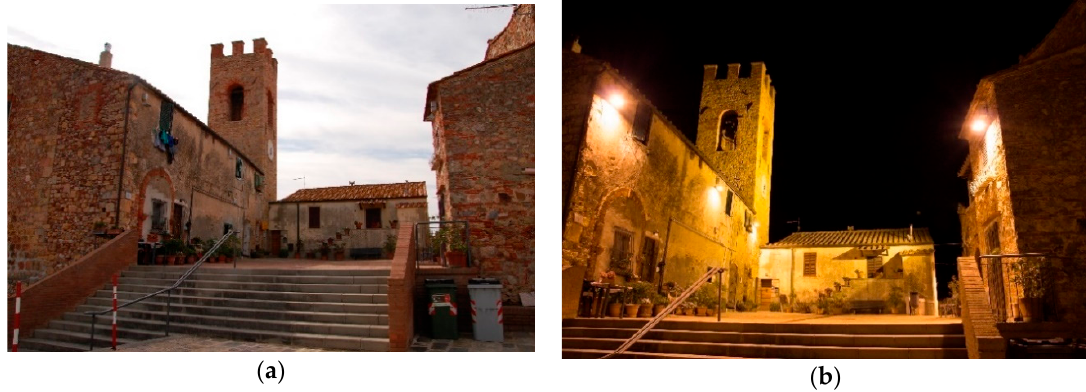
Figure 6. ( a ) day and ( b ) night photographs taken from the internal point of view I1. (Credits: Francesca Floris).